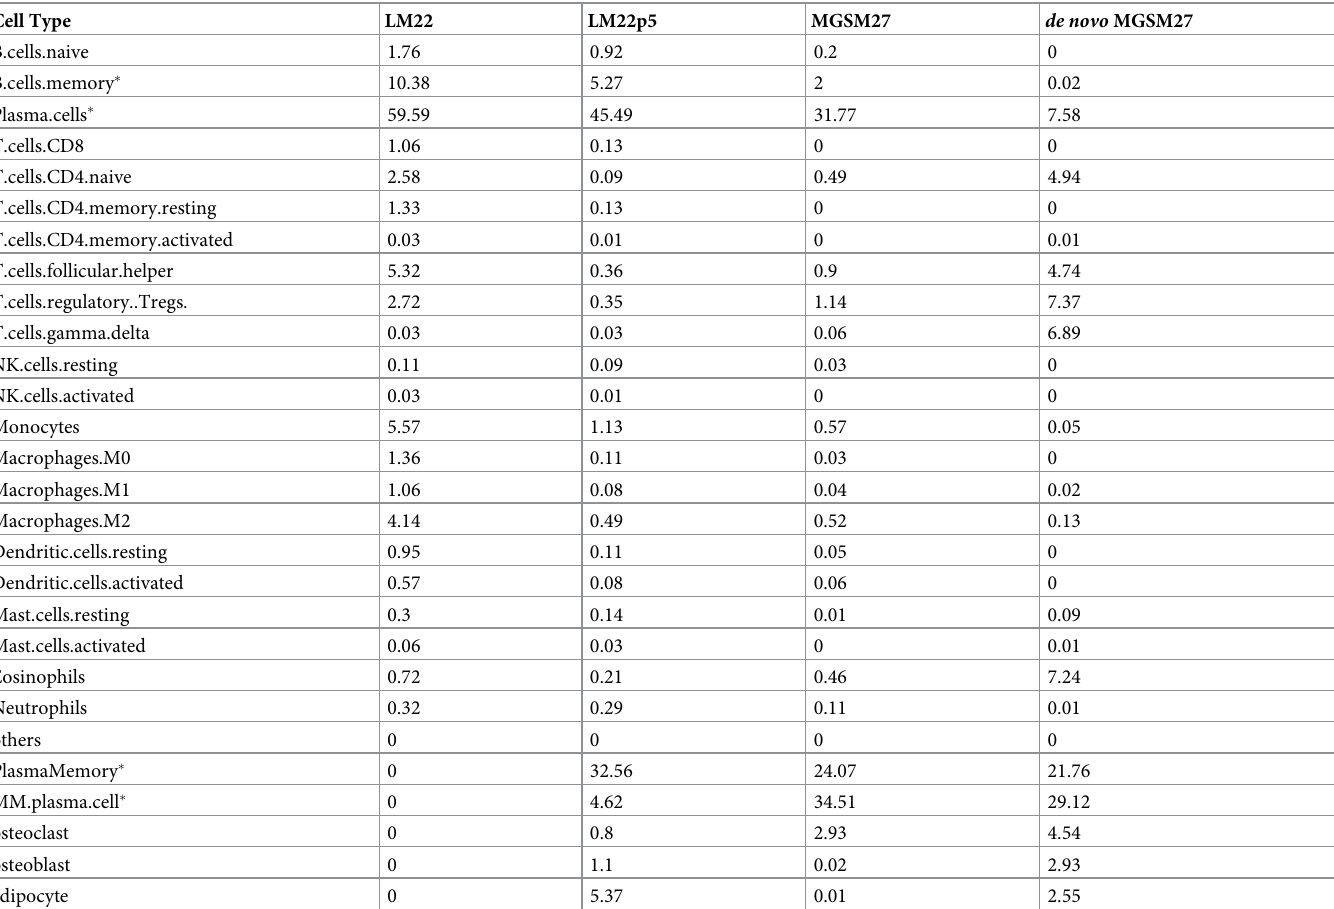
Table 2. Deconvolution of CD138 + purified